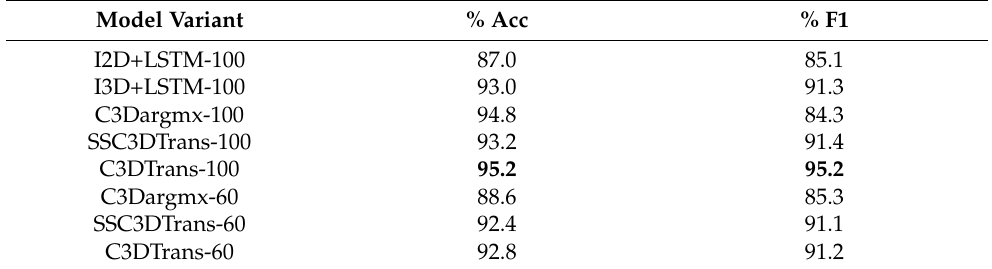
Table 5. Clip-level results of the knot-tying (KT) task. The best results column-wise are shown in bold. Model